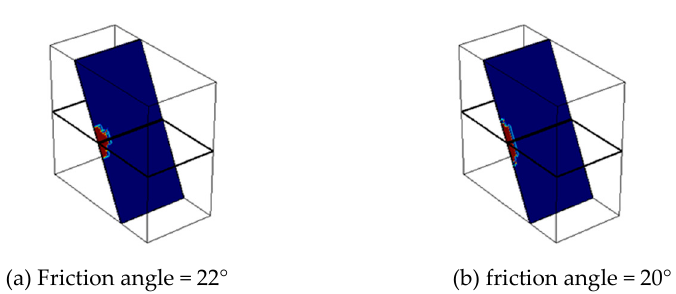
Figure 9. Effect of friction angle on extent of fault failure. Figure 9. E ff ect of friction angle on extent of fault failure. Minerals 2019 , 9 , x FOR PEER REVIEW